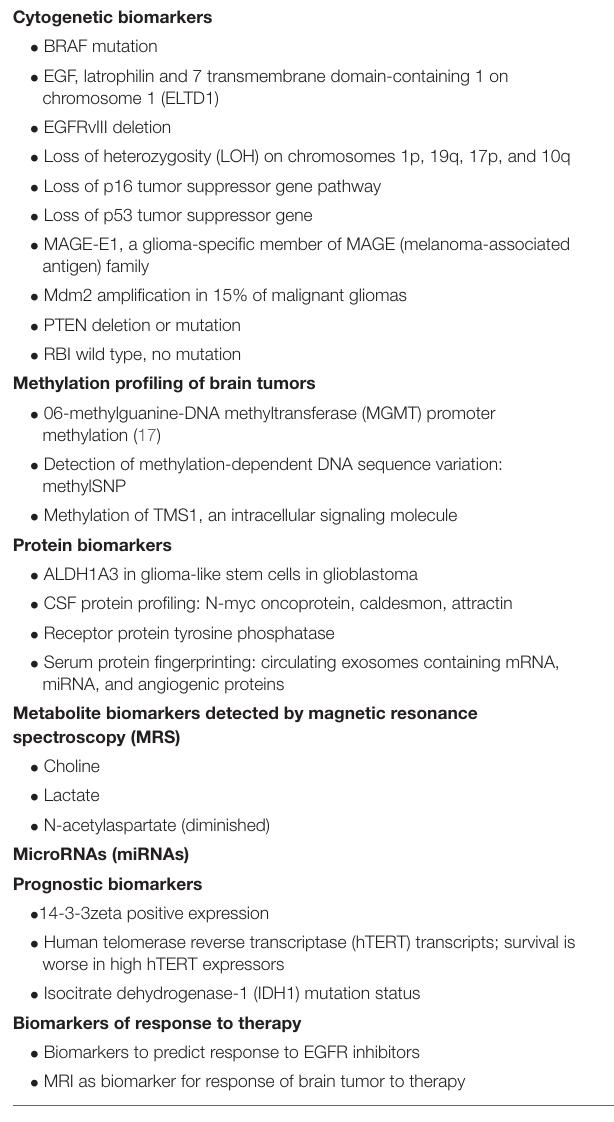
TABLE 2 | Classification of biomarkers of glioblastoma that are relevant to